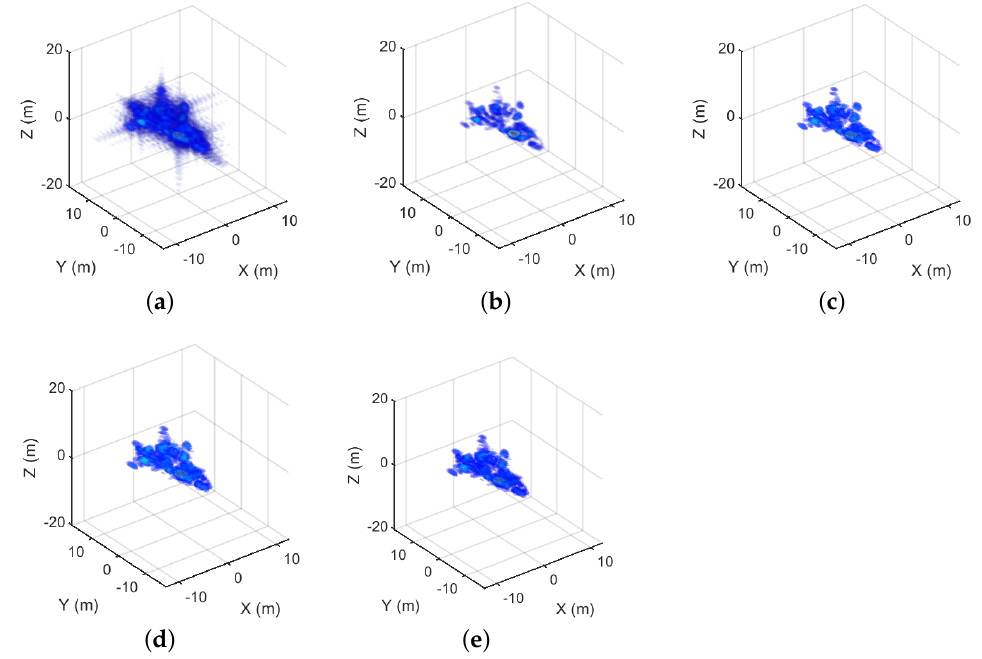
Figure 11. The imaging results of the aircraft with SNR of 10 dB. ( a ) The MF result. ( b ) The FIST result. ( c ) The SCAD result. ( d ) The MCP result. ( e ) The GSALSA–Cauchy